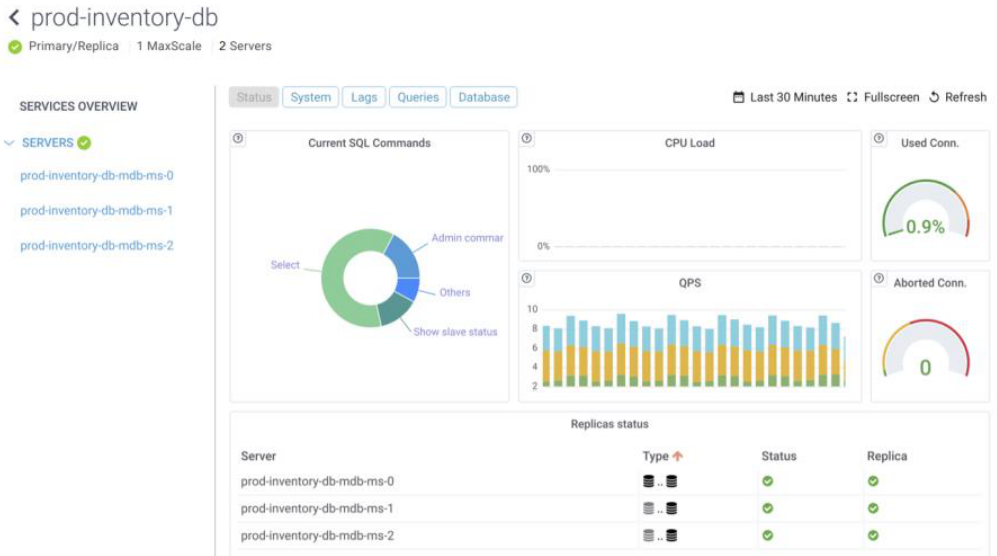
Figure 4. MariaDB Xpand v6.0.3 graphical user interface.